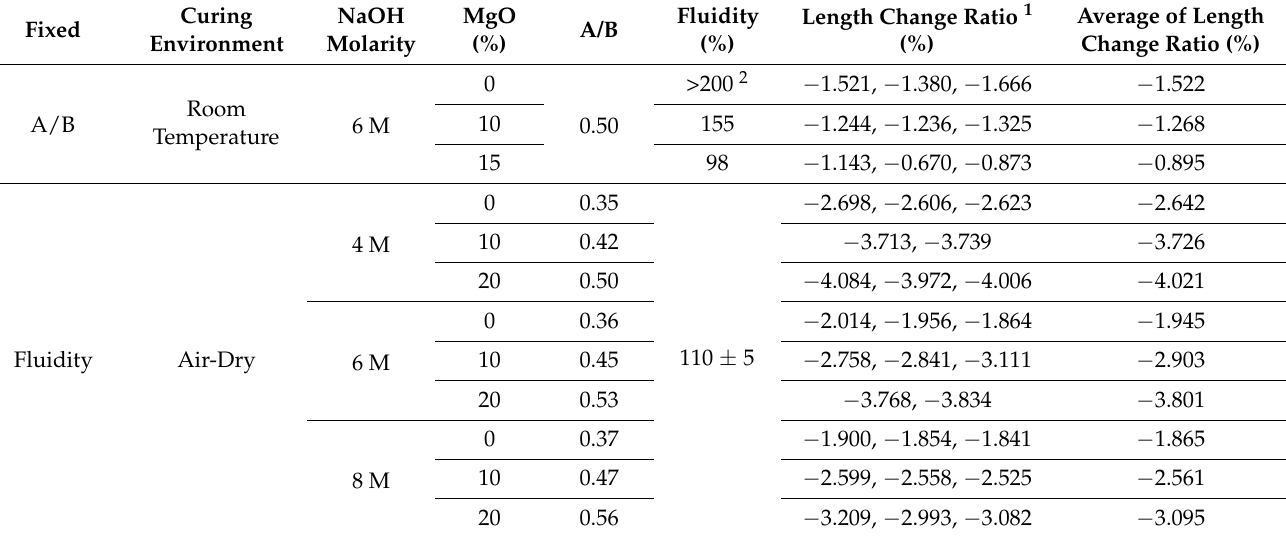
Table 4. The length change ratios of the specimens unmolded at the age of 3 h.